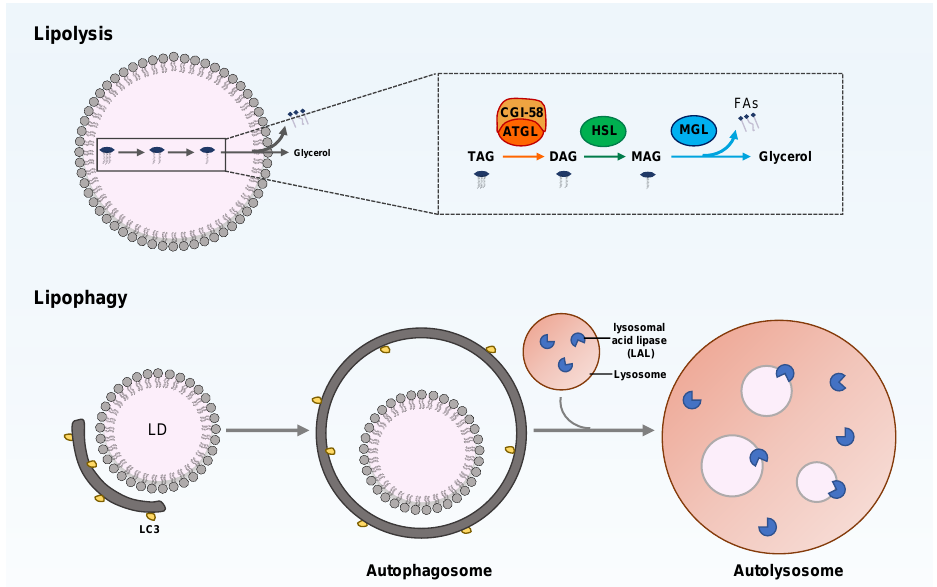
Figure 3. Overview of LD degradation through lipolysis or lipophagy. TAG breakdown in LD is catalyzed by cytoplasmic or lysosomal lipase. Lipolysis is composed of three sequential catalyzations of TAG, DAG, and MAG by adipose triglyceride lipase (ATGL), hormone-sensitive lipase (HSL), and monoacylglycerol lipase (MGL), respectively. Lipophagy belongs to selective autophagy; that is, the LDs are engulfed into the autophagosome and are then fused with lysosomes to form autolysosomes, wherein the neutral lipids in LDs are hydrolyzed by lysosomal acid lipase (LAL). Various proteins and lipases on the surfaces of LDs regulate LD catabolism. For example, perilipin is responsible for lipid homeostasis by controlling the availability of lipases to neutral 58 (CGI-58) in an inactive state. Under starvation conditions, perilipin is phosphorylated by hydrolysis of TAG [80]. The phosphorylated perilipin can also add phosphate to the hormone- sensitive lipase (HSL) and transfer it to LDs. The HSL hydrolyzes DAG into